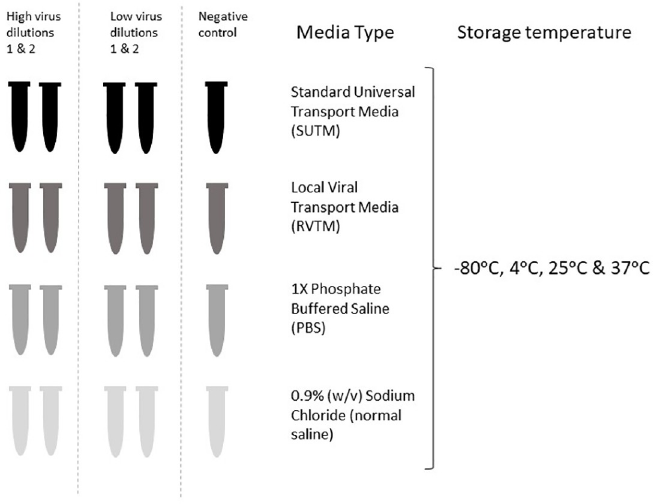
Fig 1. An illustration showing virus dilutions in different media types and different virus inoculation temperatures. Each media type was made up of 2 tubes inoculated with high virus concentrations, 2 tubes of low virus concentrations and 1 negative control (no viral inoculum) tube, generating a total of 5 tubes stored at the following temperatures: -80˚C, 4˚C, 25˚C (room temperature) and 37˚C and subsequently used to extract RNA for qRT-PCR on days 1, 2, 3, 4 and 7. Thus, each media type consisted of a total of 80 tubes, that were subsequently extracted for RNA to conduct the qRT-PCR.